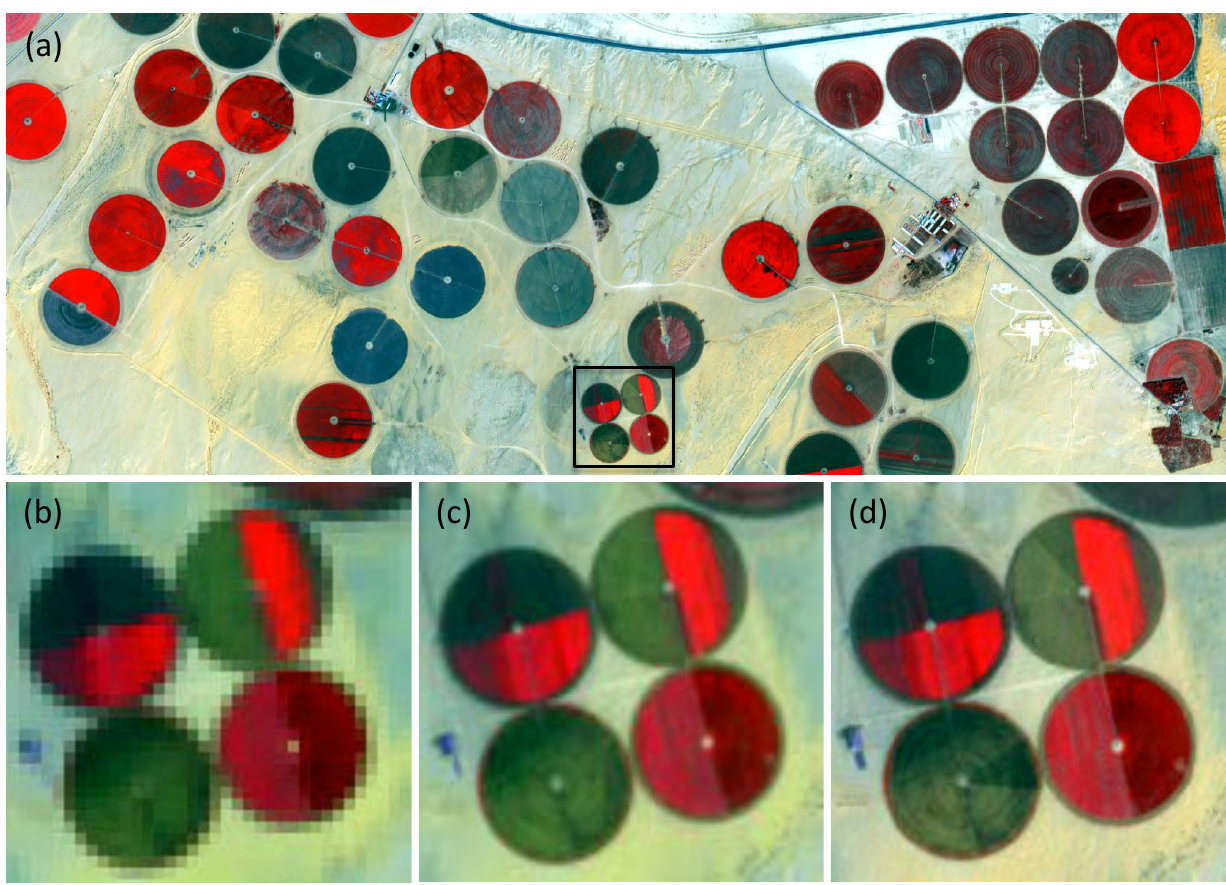
Figure 4. Multi-scale capabilities of state of the art sensing optical satellites. Image illustrates the expanding resolution options available from both commercial and government satellites. (a) Planet CubeSat at 3m ground sampling distance over the Tawdeehiya Farm in Al Kharj, Saudi Arabia. Centre-pivot irrigated fields dot the landscape, with dimensions approaching 800m. The inset in (a) is zoomed to show the resolution advantages offered by the next generation of sensing solutions over (b) Landsat-8 at 30m, with (c) Sentinel-2A at 10m and (d) Planet imagery at 3m providing enhanced details. All images are false colour representations of NIR, red and blue in RGB bands. Sentinel-2A and Landsat-8 images were acquired on 4 December 2016, while the Planet data were captured on 5 December